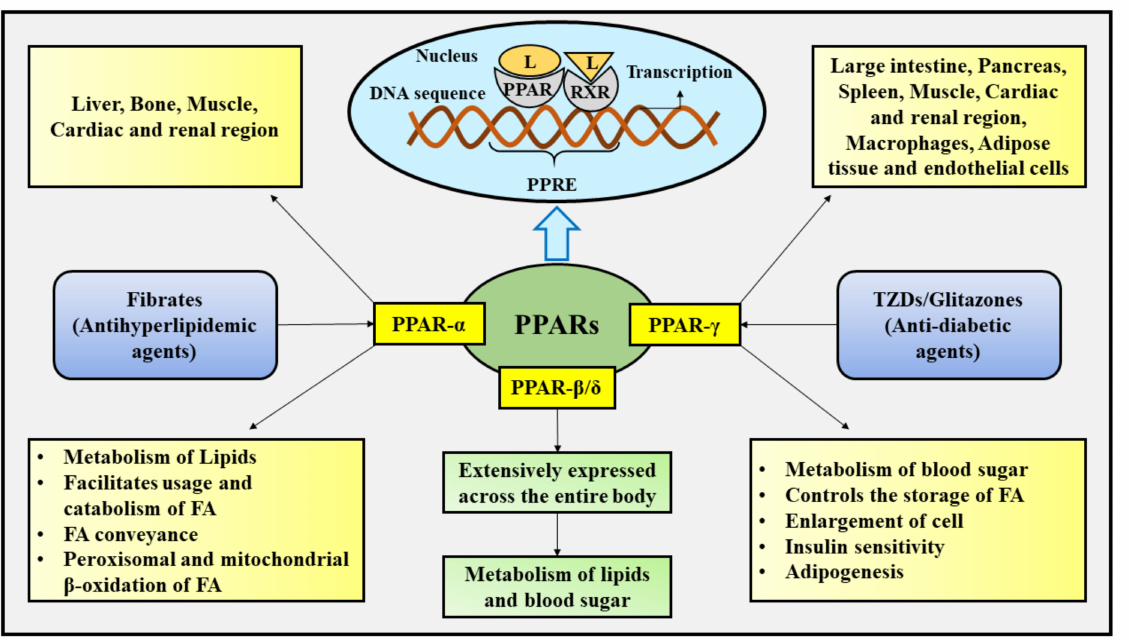
Figure 1. Location, ligand-based activation, functions, and transcriptional activation of PPARs. FA, fatty acids; L, lig- and; PPARs, Peroxisome proliferator-activated receptors; RXR, retinoid X receptors; DNA, deoxyribonucleic acid; PPRE, peroxisome proliferator response element; TZDs,